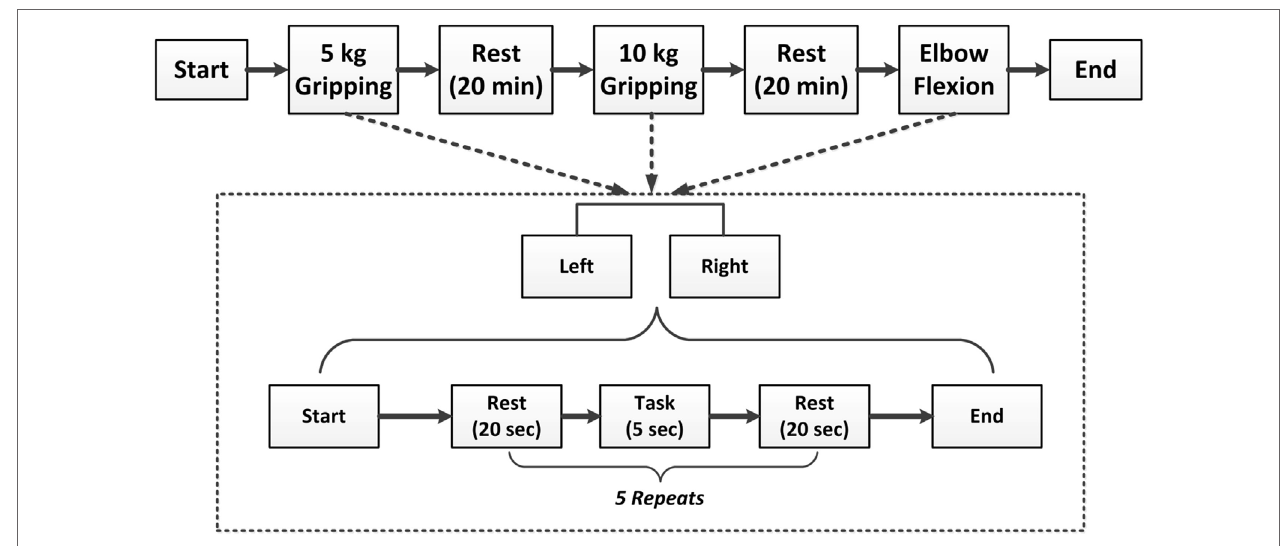
FigUre 1 | Illustration of the experimental